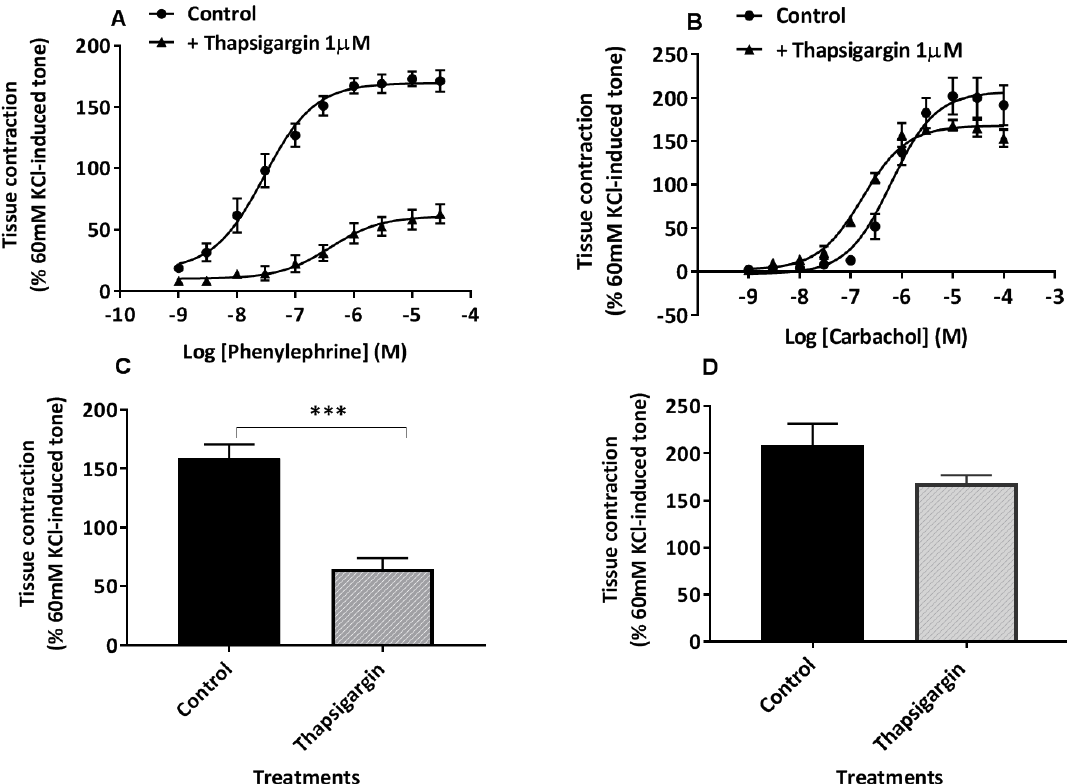
Figure 3: Effect of thapsigargin pre-incubation on agonist concentration response curves (CRCs) in rat isolated (A) aorta and (B) trachea. Maximum response (E max ) of agonist CRCs between control and in the presence of thapsigargin are depicted in (C) aorta and (D) trachea. Tissue responses have been expressed as a percentage of 60mM KCl-induced-contraction and are shown as means ± SEM of 3 to 8 animals (unpaired t-test : *** p